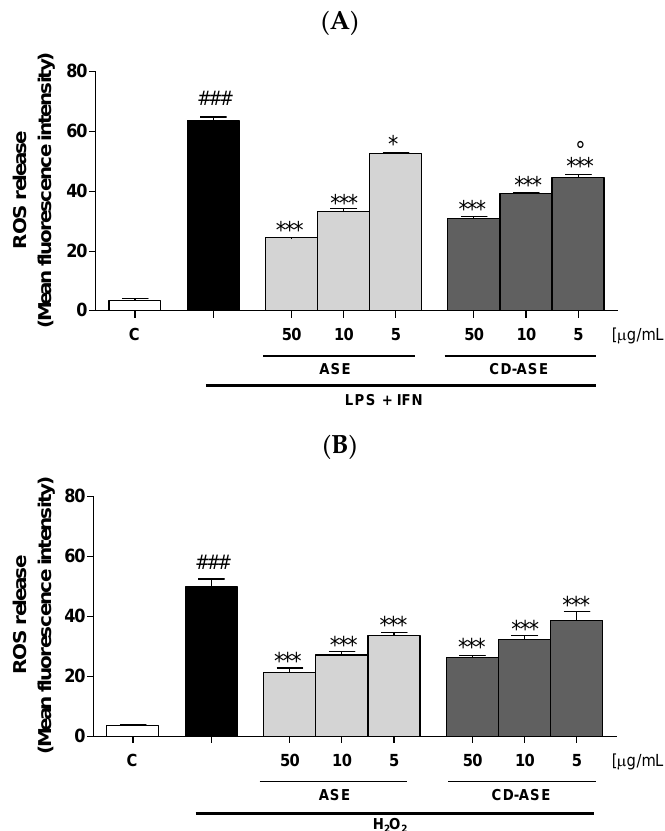
Figure 9. Effect of Acetonic almond skins extract (ASE), and formulation (CD-ASE; 50–5 µg/mL) on intracellular ROS release, in LPS + IFN ( A ) and H 2 O 2 ( B )-IEC-6 treated cells, detected by the probe of 2′,7′ dichlorofluorescein-diacetate (H 2 DCF-DA). Data are expressed as mean ± SEM of mean fluorescence intensity. *** and * denote respectively p < 0.001 and p < 0.01 vs. LPS + IFN or vs. H 2 O 2 ; ° denotes p < 0.05 vs. ASE; ### denotes p < 0.001 vs. control (C).